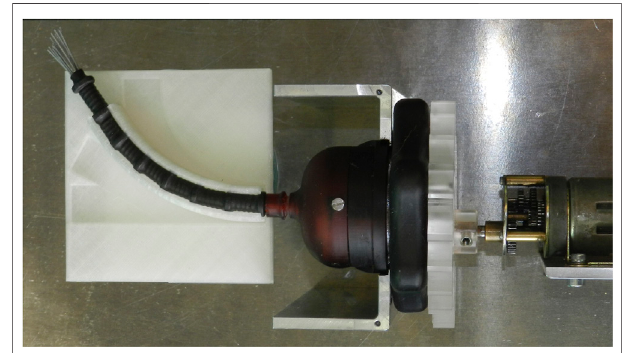
FIGURE 11 | Photo showing the fl exible shaft of the transport mechanism placed inside the 30 ° curved